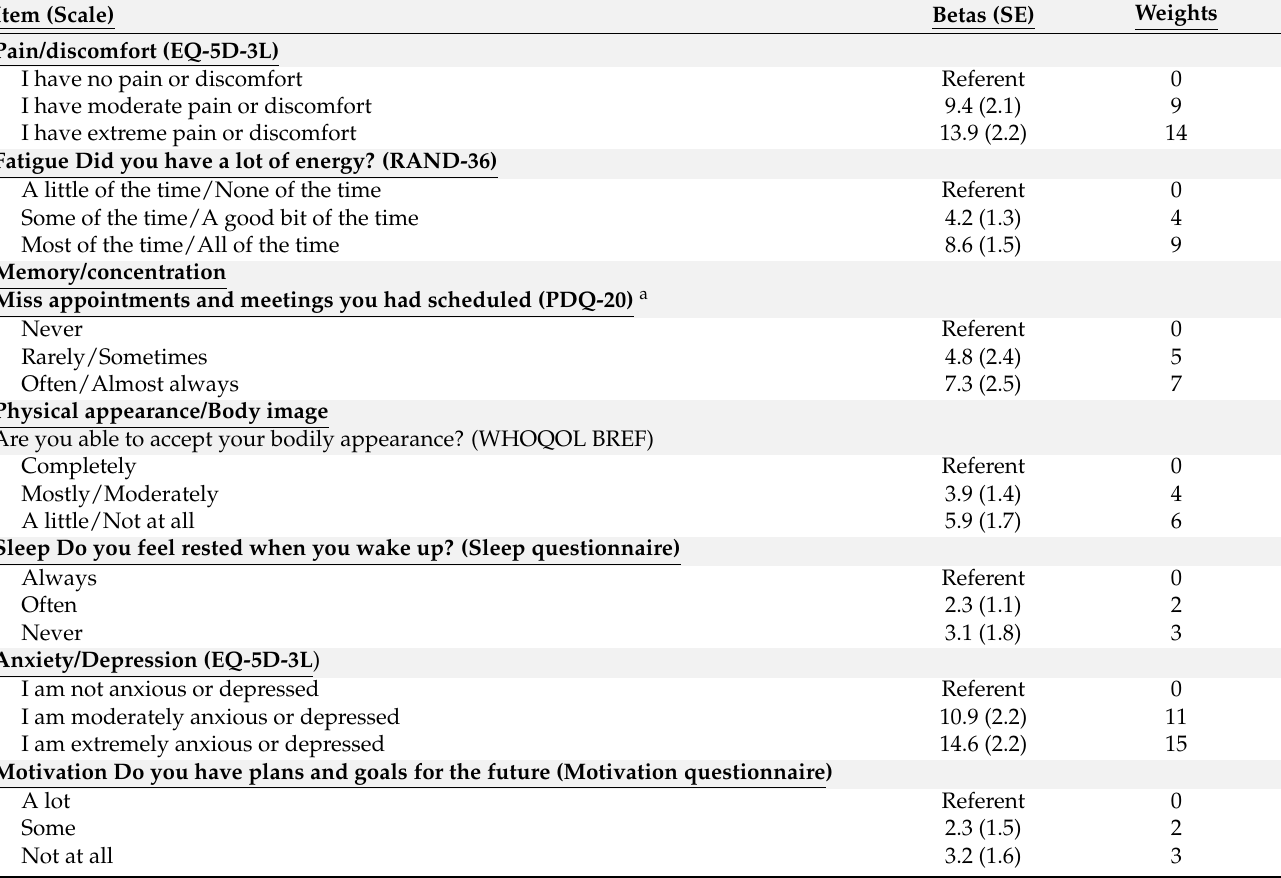
Table 2. Items (original wording) with unstandardized (Beta) coefficients and weights.